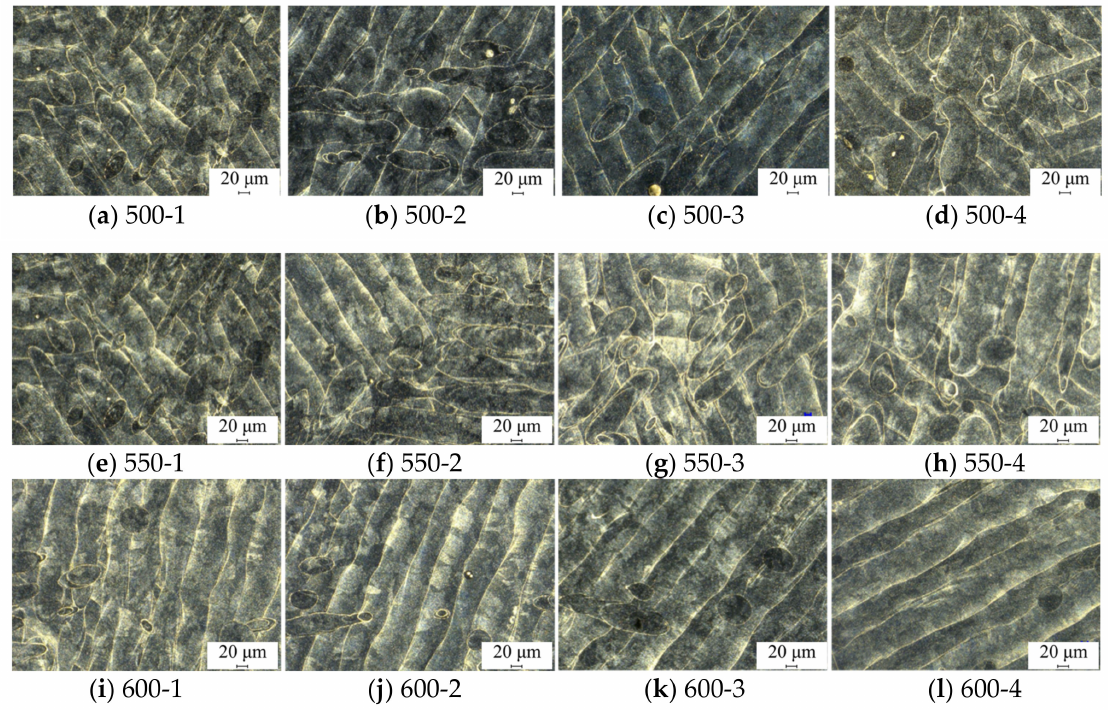
Figure 8. The metallographic of 316L samples fabricated with different shielding gas volume